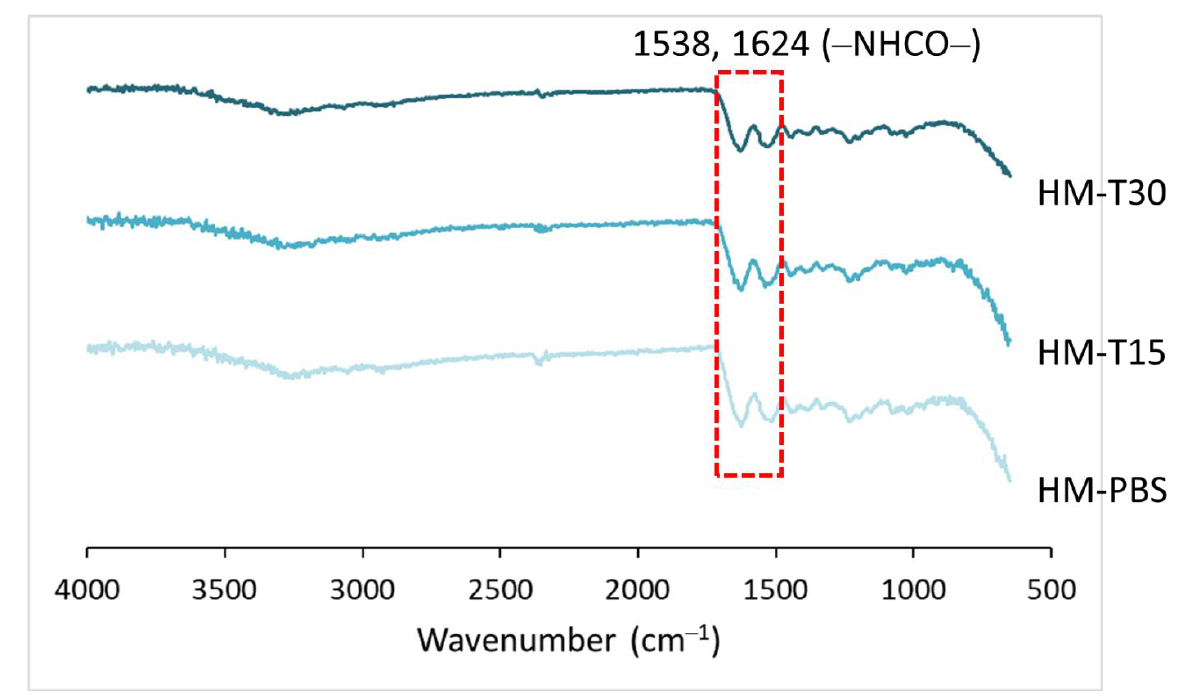
Figure 2. FTIR spectra of hyaluronic acid and gelatin cross-linked with EDC and loaded with temo- porfin.